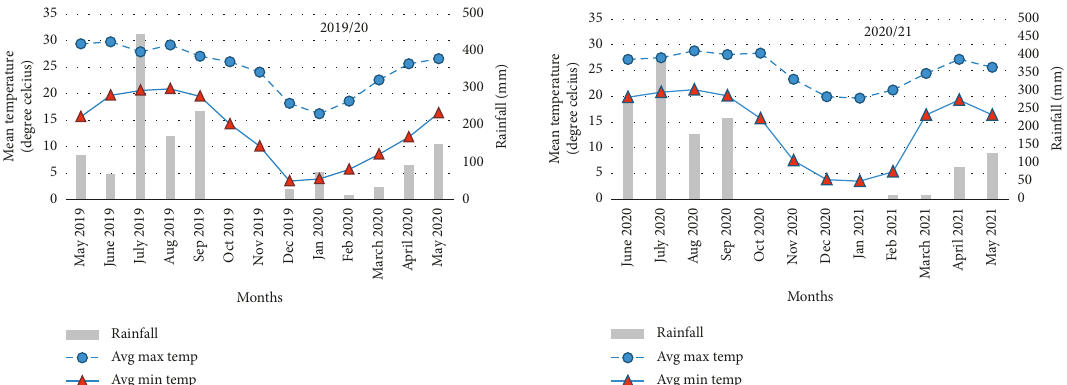
Figure 1: Monthly mean maximum, mean minimum, and total rainfall at Khumaltar, Lalitpur, Nepal, during 2019/20–2020/21. Table 1: Physicochemical properties of the experimental plot before field experiment at Khumaltar, Lalitpur, Nepal, 2019. Parameters Soil test values Method followed